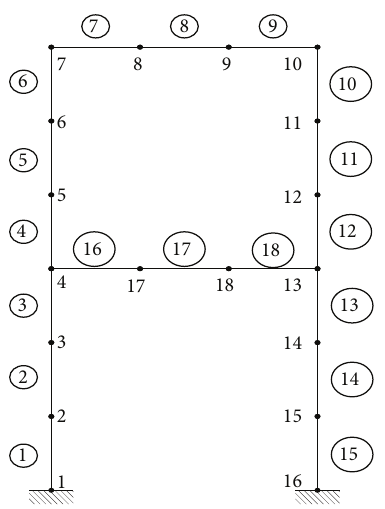
Figure 6: Two-storey plane frame as considered by Yu and Xu [9].